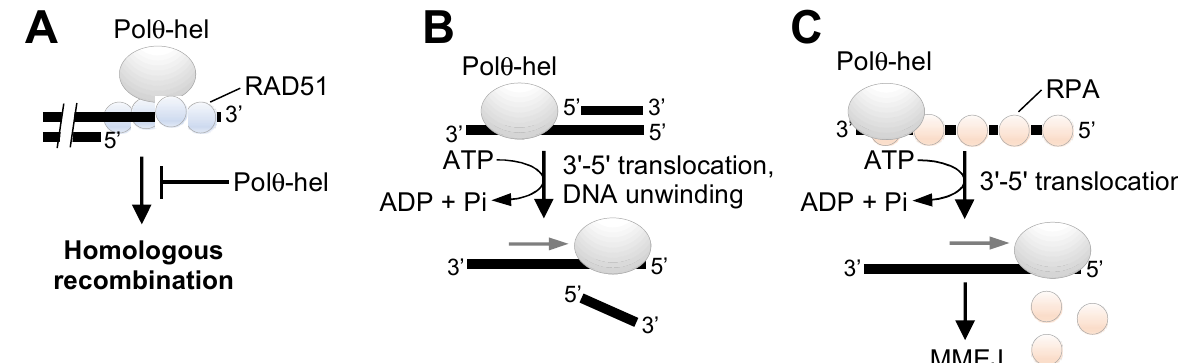
Figure 3. Biochemical mechanisms of Pol θ helicase. ( A ) Pol θ -hel was reported to interact with RAD51 and suppress HR and toxic RAD51:DNA intermediates via its ATPase activity. ( B ) Pol θ -hel was shown to unwind short double-strand DNA with 3 ′ –5 ′ polarity in an ATP hydrolysis-dependent manner. ( C ) Pol θ -hel was shown to dissociate RPA from ssDNA in an ATP hydrolysis-dependent manner, and evidence indicates that this activity stimulates MMEJ.